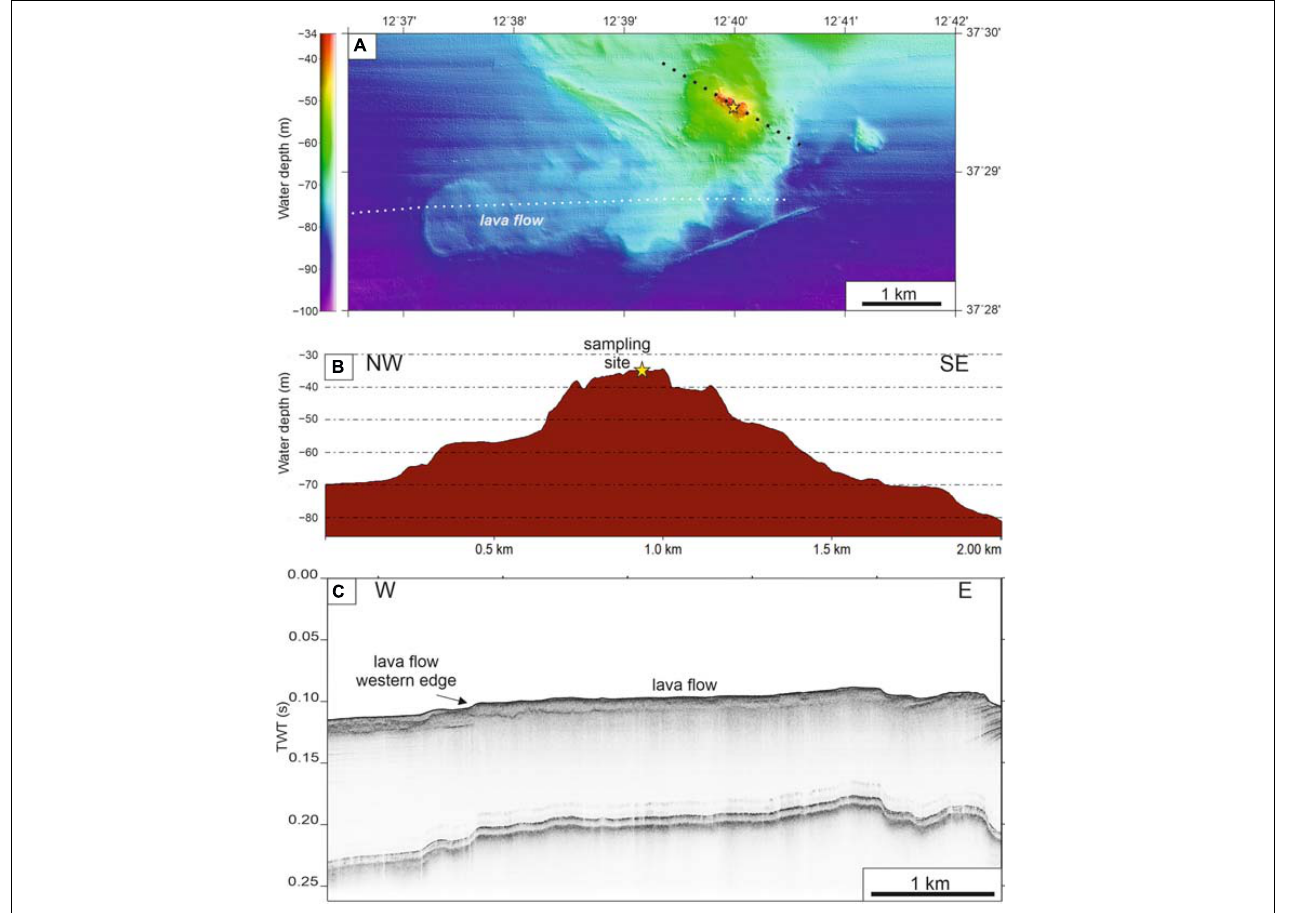
FIGURE 2 | (A) Shaded-relief of the high-resolution swath bathymetry of the Actea volcano. Black dashed segment indicates the location of the bathymetric profile in panel (B) , with the location of the sampling site (yellow star); white dashed segment indicates the location of the high-resolution seismic profile displayed in panel (C) , which crosses W-E the large lava flow, where no sediment cover is found. These geophysical data have been acquired on February 2018 by the R/V OGS Explora . Details on instruments and acquisition parameters, and on data processing can be found in Lodolo et al. (2019a).